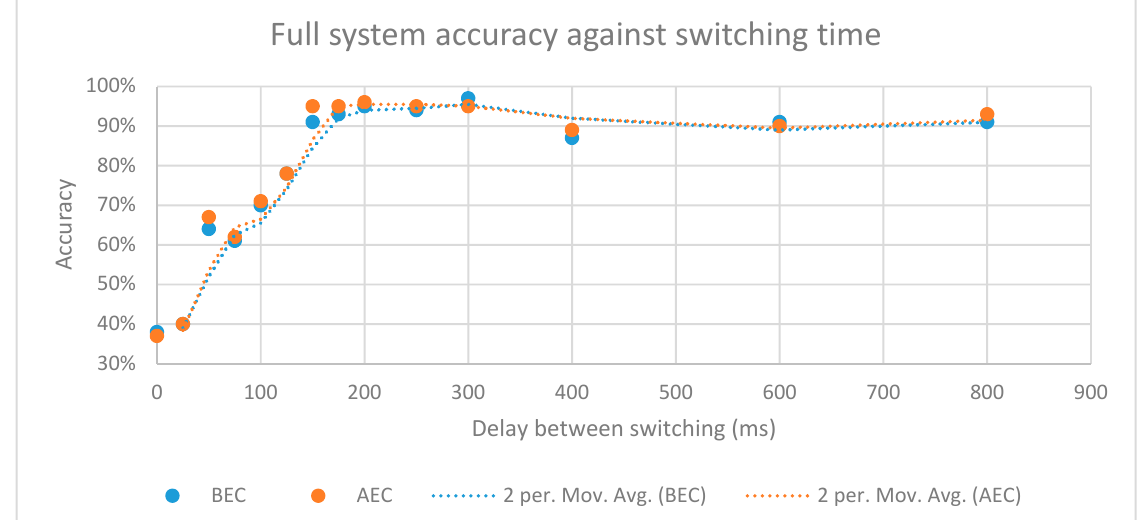
Figure 6. Full e-textile sensor system response against switching